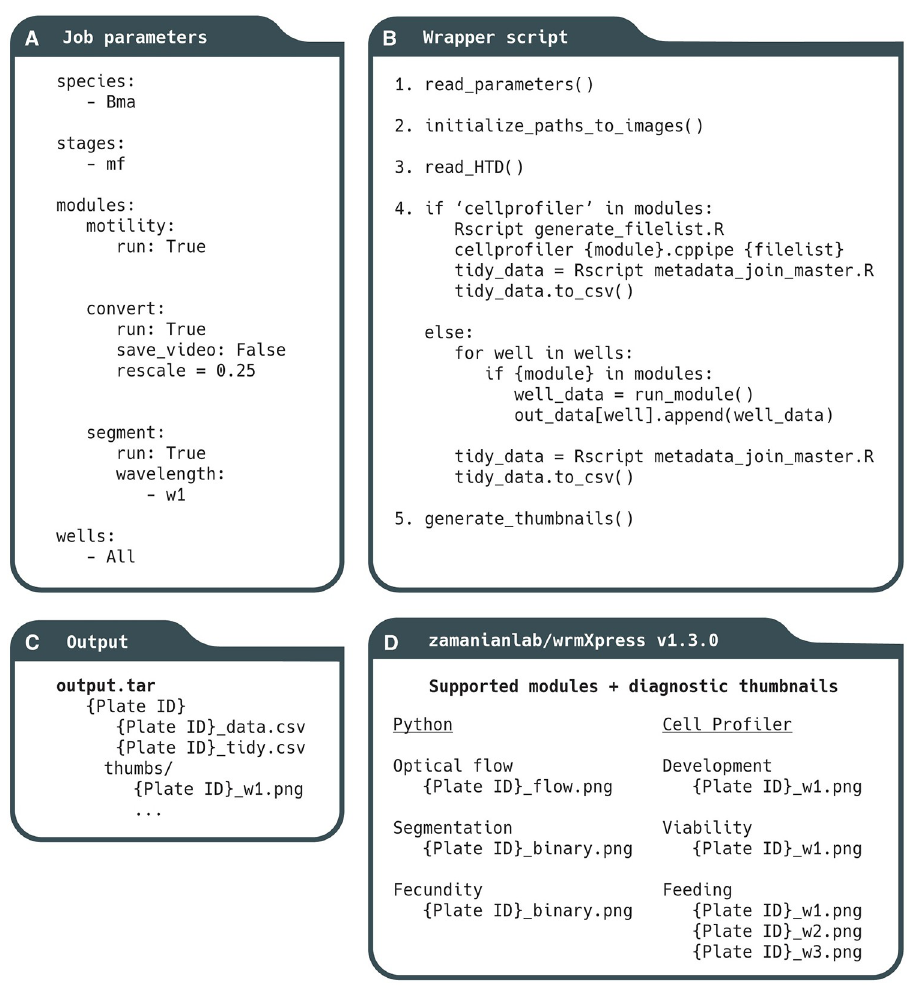
Fig 2. Constituents of the wrmXpress workflow. (A) Jobs are parameterized with a user-generated YAML file, which includes species and stage information, and allows for the selection of Python or CellProfiler modules. (B) The wrapper script controls the implementation of wrmXpress. (C) Output data includes raw data, raw data with joined metadata, and diagnostic thumbnail images. (D) wrmXpress comes packaged with 6 distinct analytical